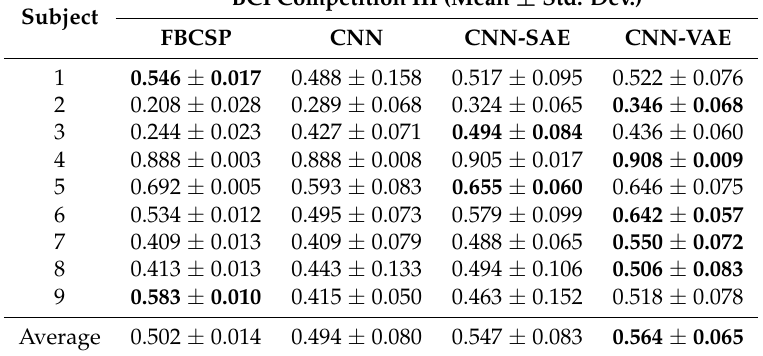
Table 2. Comparison of kappa value and standard deviation for CNN-VAE and 3 Competitive methods on BCI competition IV dataset 2b. (The data in bold is the best performance among the different